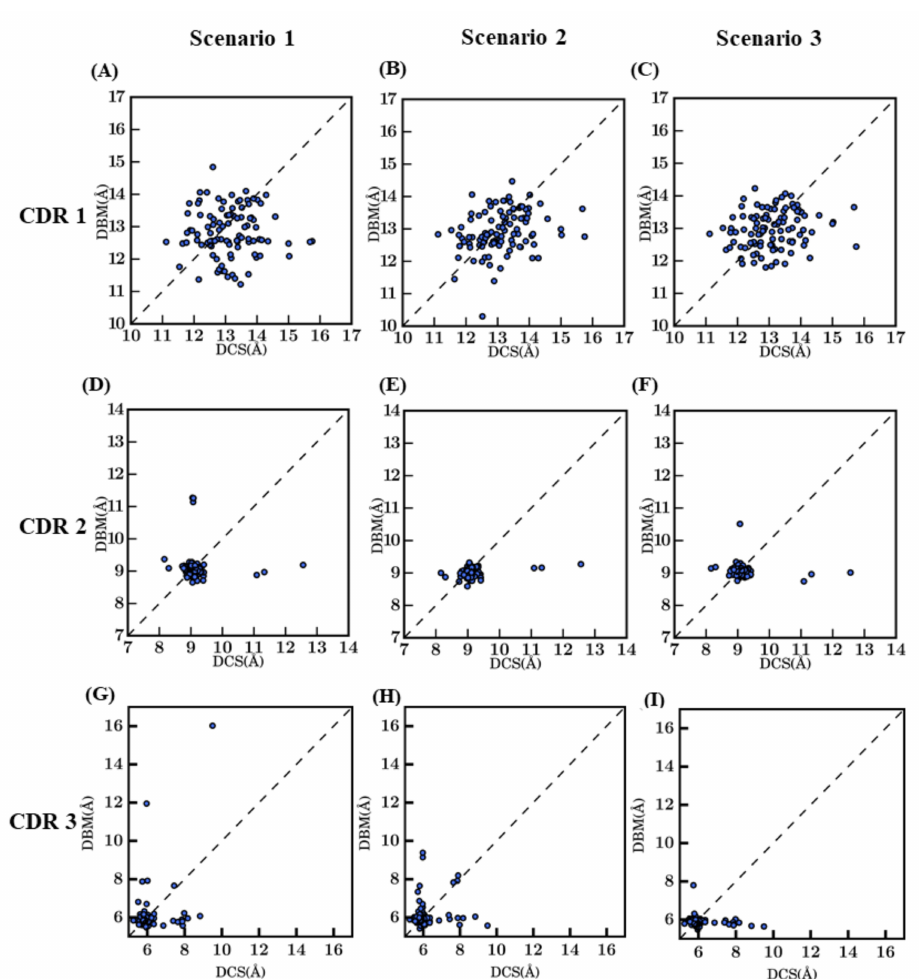
Figure 5. Distance between the C α residues of CDR termini in crystal structures and corresponding selected models. ( A ) to ( C ) CDR1, ( D – F ) CDR2, and ( G , H ) CDR3, scenario 1— bestSeqIdTemp , corre- sponds to ( A , D , G ), scenario 2— bestStructTemp to ( B , E , H ), while scenario 3— 3bestSeqIdTemp is ( C , F , I ). The x -axis values represent the distance observed in crystal structure (DCS (Å)) and the y -axis values the distance observed in the best model (DBM